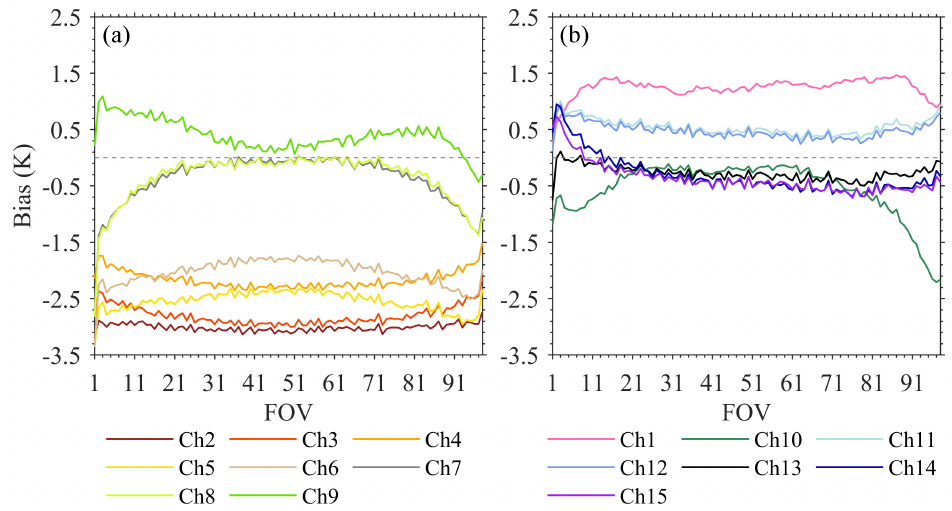
Figure 7. Variations of the biases for ( a ) the 118-GHz channels and ( b ) the other channels with FOVs using the NCEP FNL data as the background